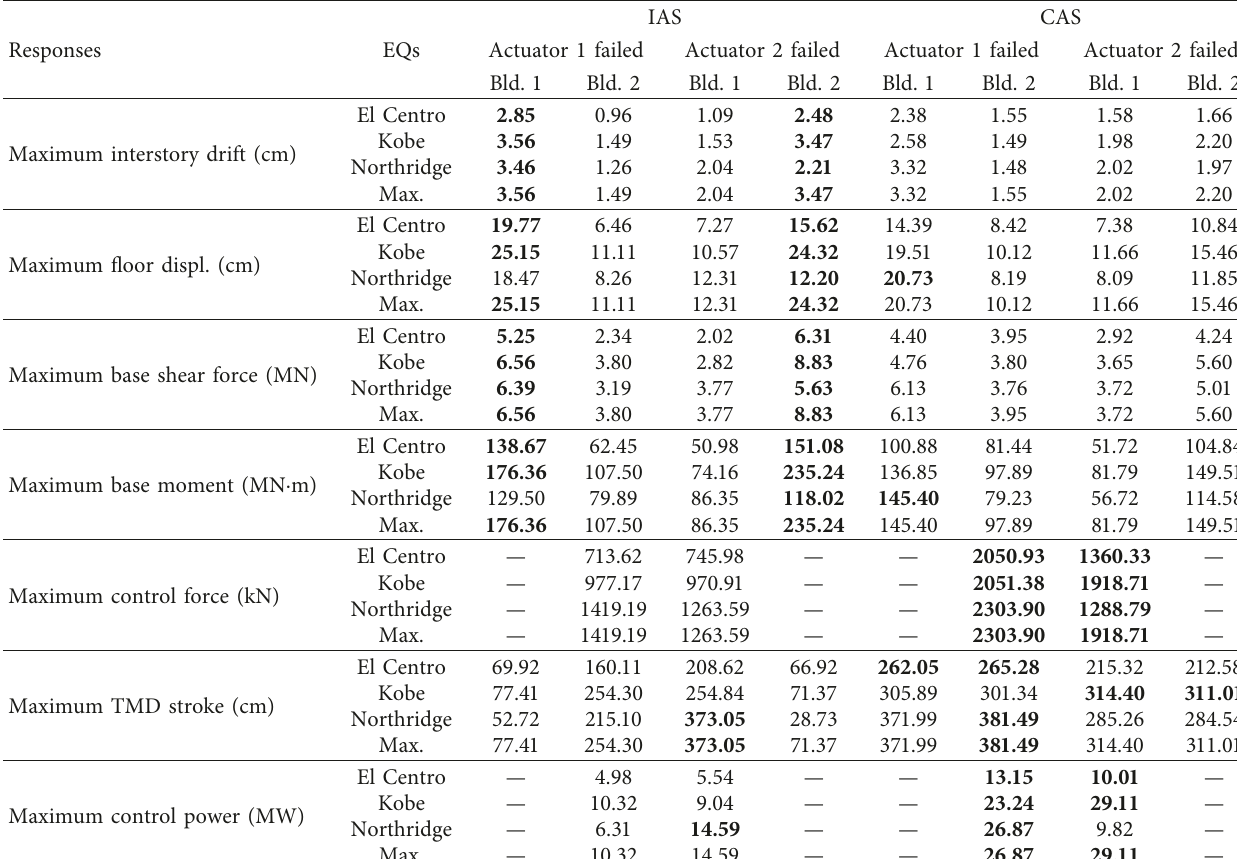
Maximum interstory drift (cm)